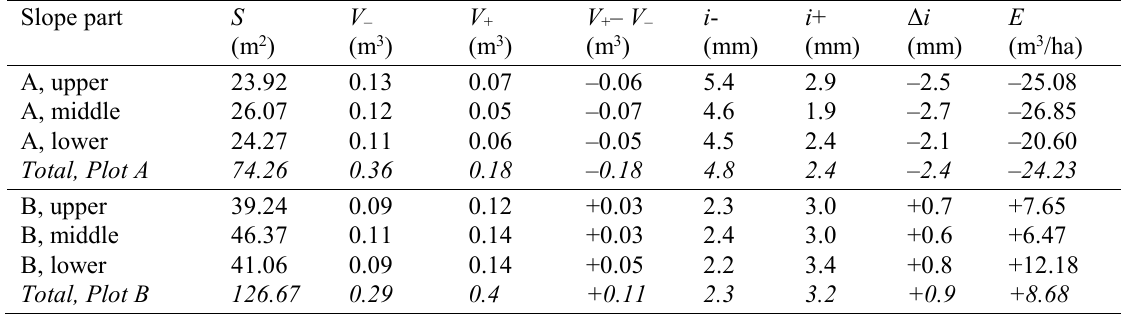
Table 2 Results of data processing 4 and 18 October 2013 (A and B